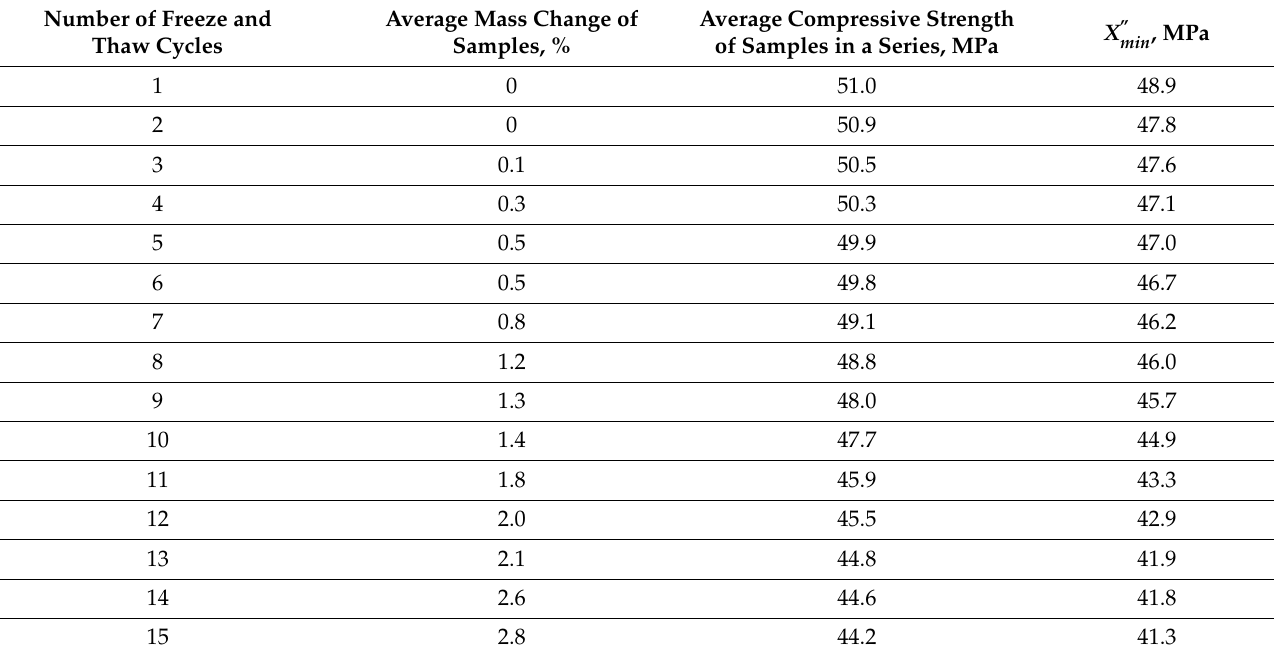
Table 10. Results of tests of centrifuged samples subjected to alternate freezing and